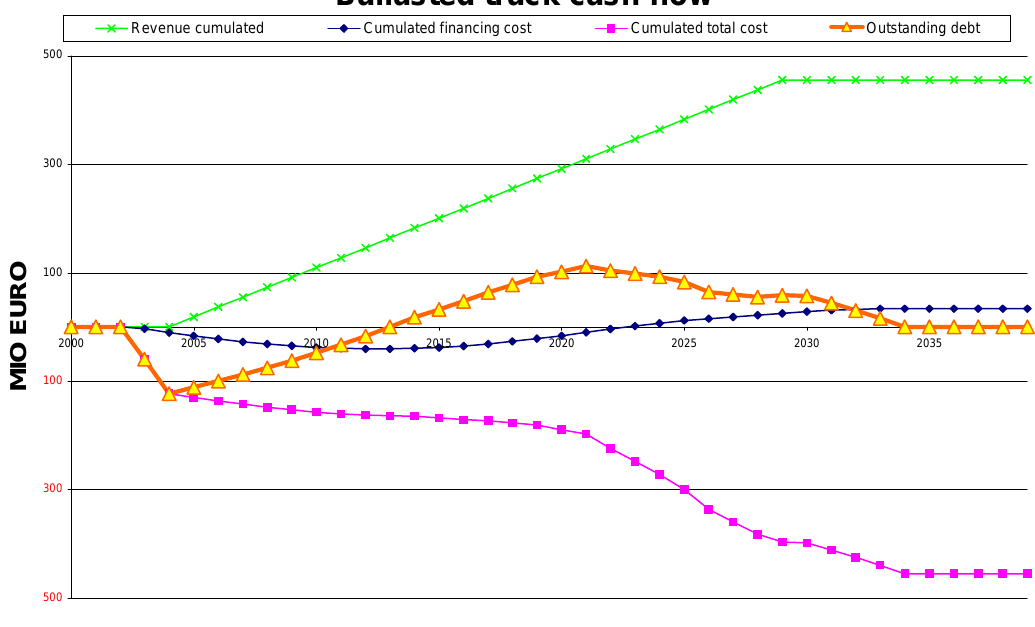
Figure 9. Cash flow for a track structure (for illustration purposes